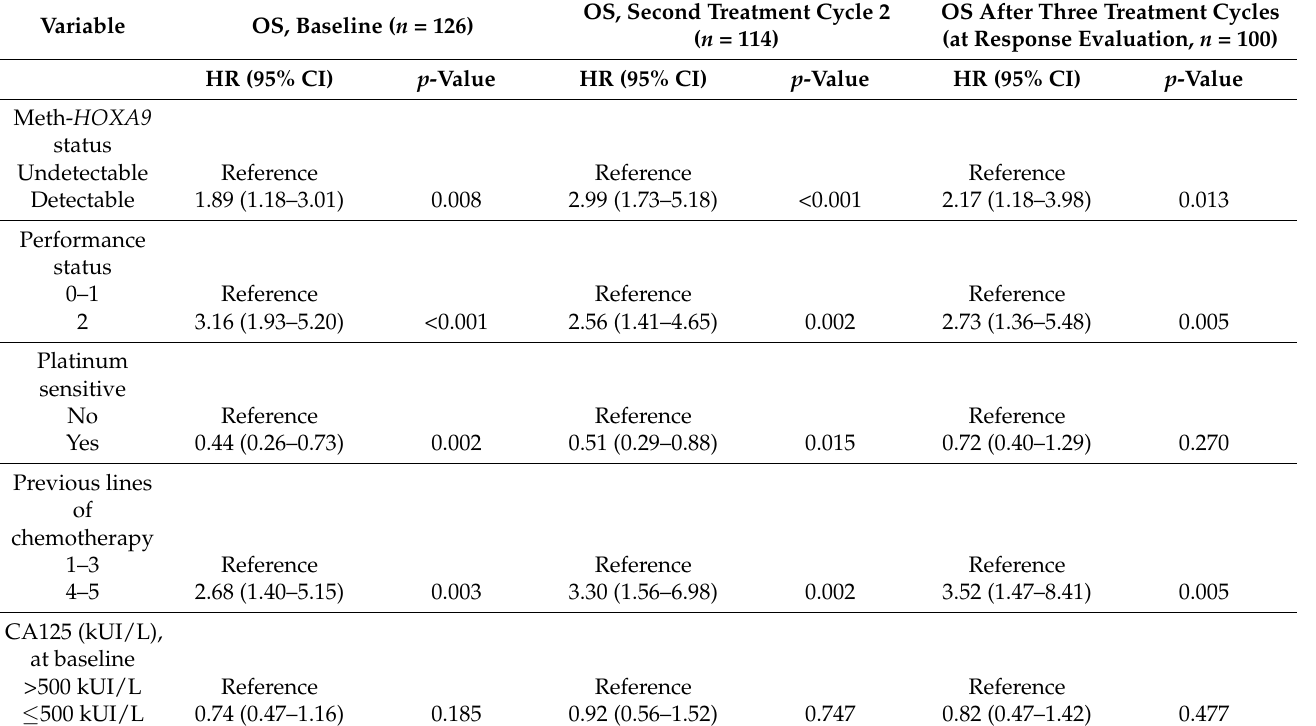
Table 2. Multivariate Cox regression